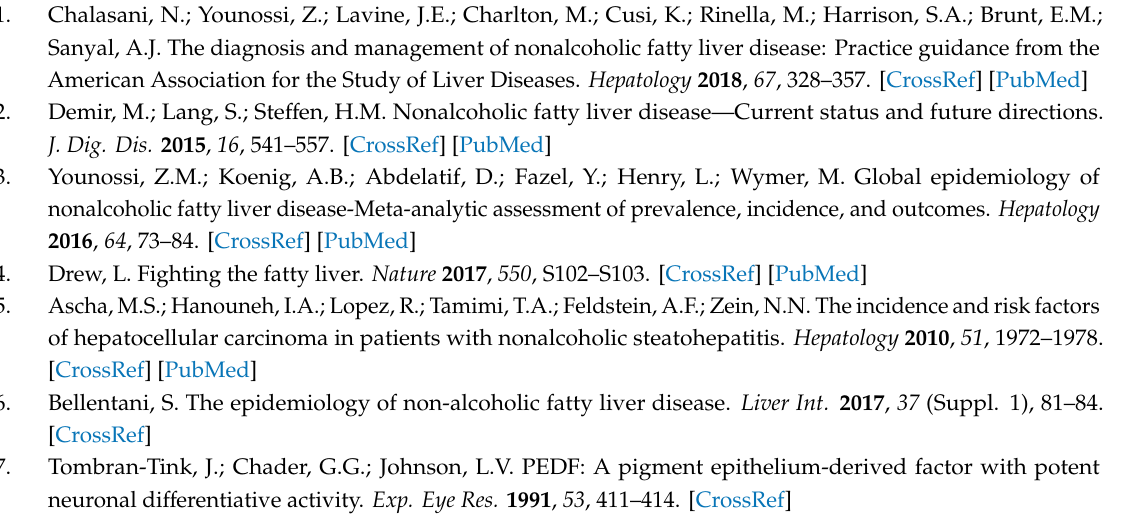
Figure S1: Mice on a CDAA diet develop hepatic fibrosis, Table S1: List of primers used in this study, Table S2: Subnetwork analysis of 2258 upregulated DEGs (siPEDF vs. siCON), Table S3: Subnetwork analysis of 2473 downregulated DEGs (siPEDF vs.